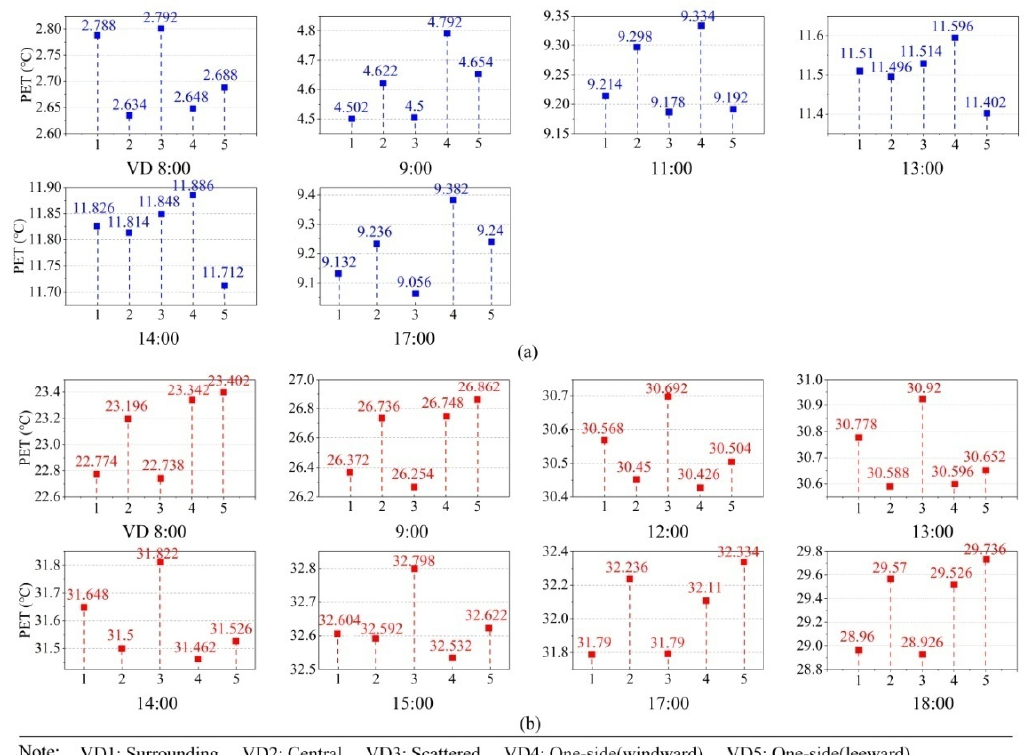
Figure 13. Effect diagrams of VD (vegetation distribution) in winter and summer: ( a ) effect diagrams of VD in winter and ( b ) effect diagram of VD in summer.